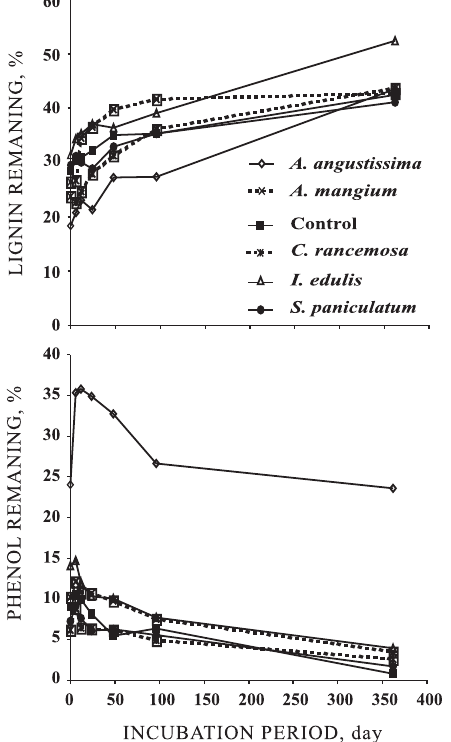
Figure 9. Percentages of lignin and phenol remaining in mulch from different enriched legumes trees and natural fellow as